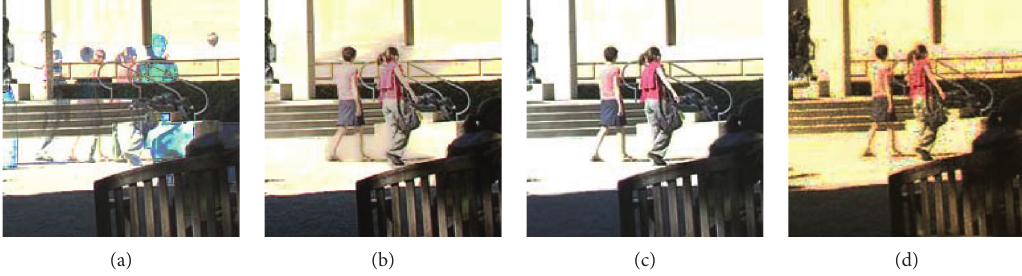
Figure 10: Details of the fusion result in Figure 9. (a) Reference [2]. (b) SEN [25]. (c) HU [30]. (d)